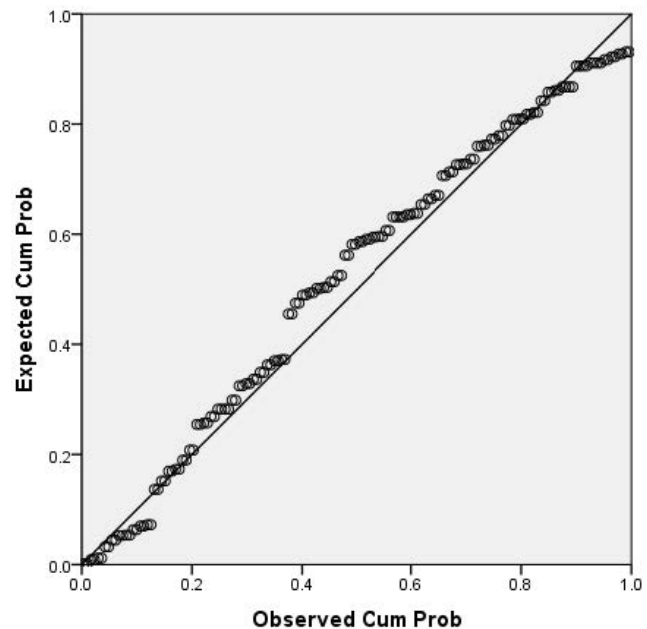
Figure A1. Normal Q–Q plot for the quality of life model residuals.